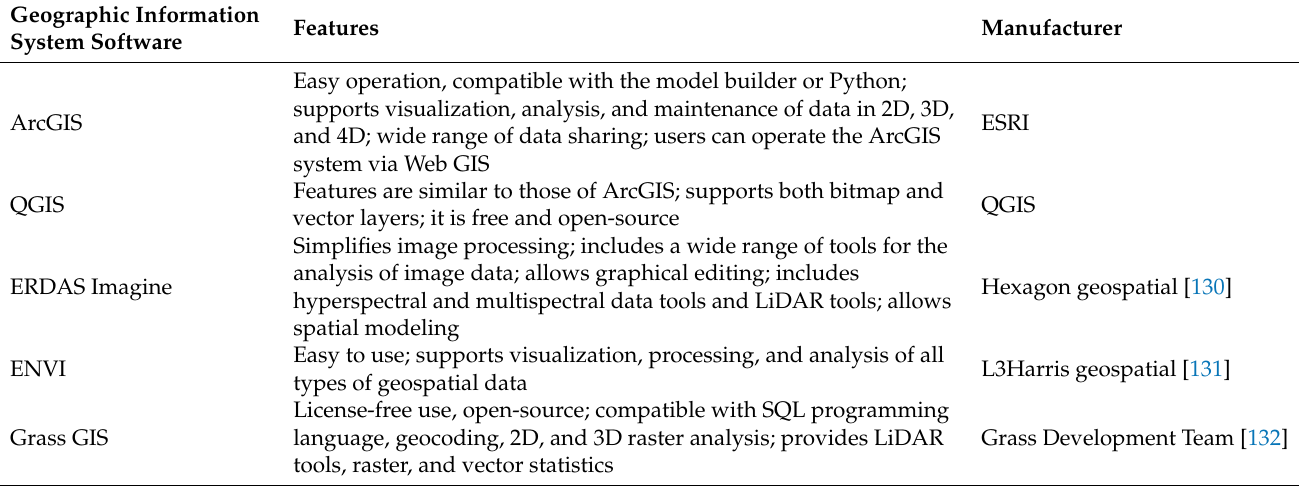
Table 3. List of recent geographic information system software used for unmanned aerial vehi- cles